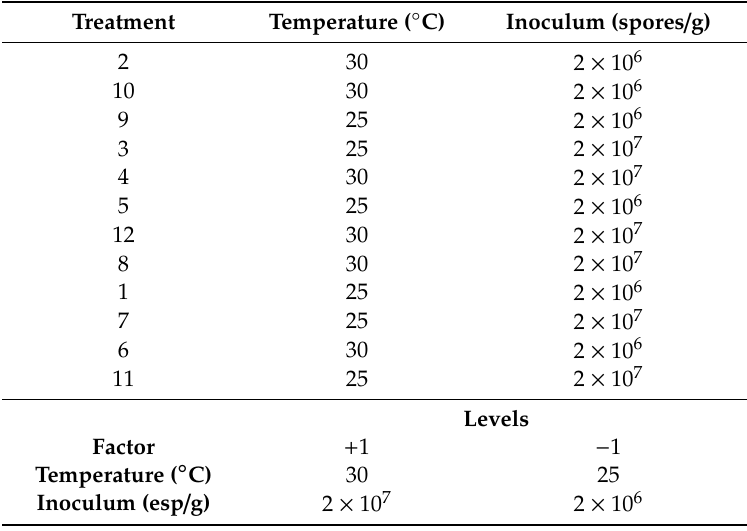
Table 1. Treatment matrix of experimental design Box Hunter &